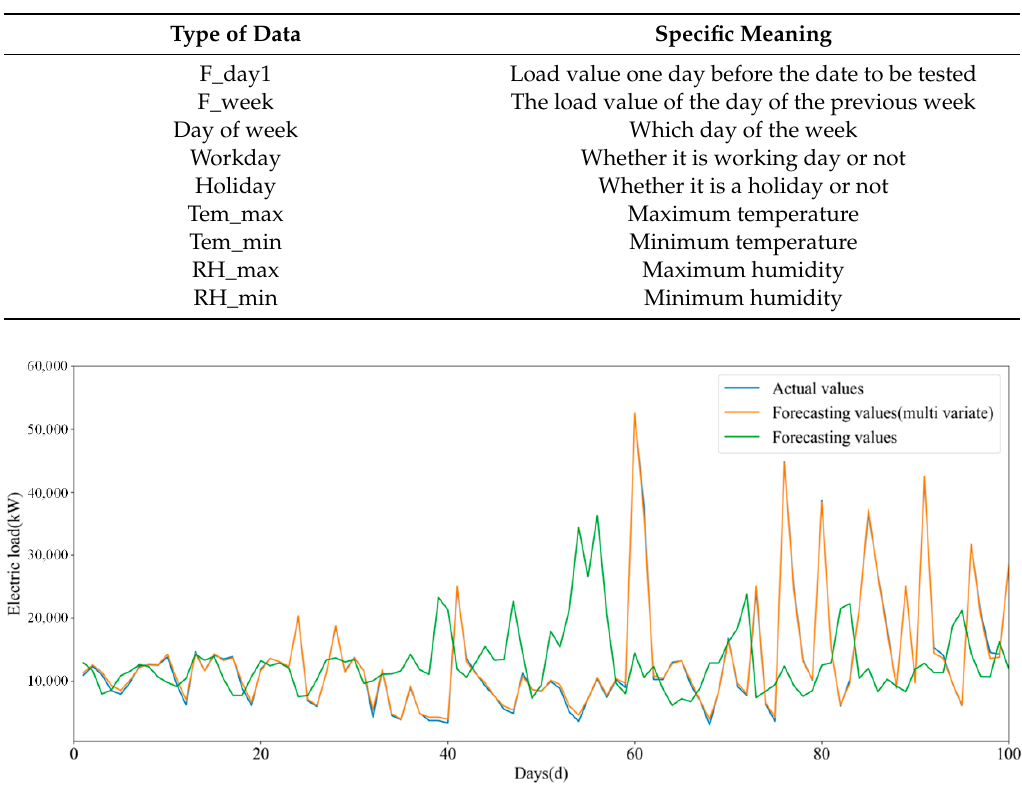
Table 5. The specific meaning of input data.